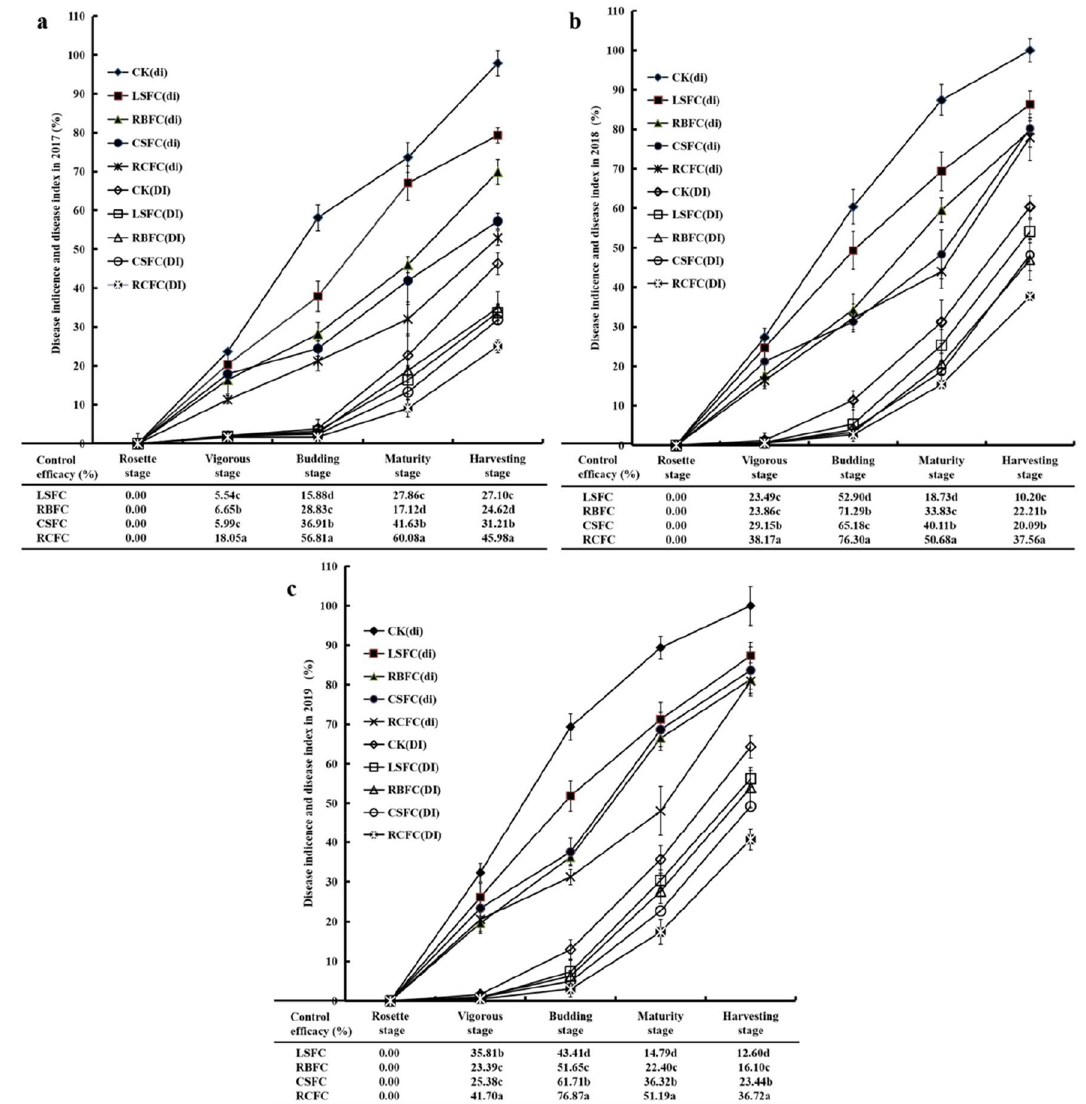
Figure 1. Disease incidence, disease index and control efficacy of five treatment groups at different stages in 2017 ( a ), 2018 ( b ) and 2019 ( c ). (The different letters in the same column indicate significant differences as determined by LSD test. p <